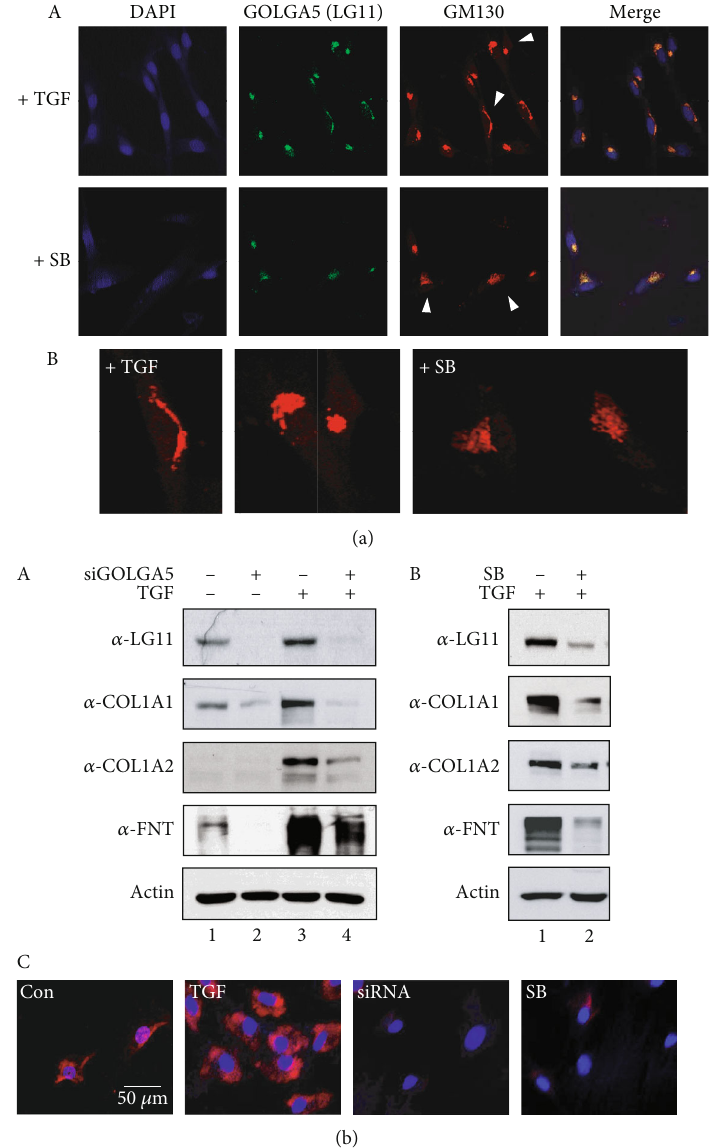
Figure 5: GOLGA5/LG11 is involved in synthesis of ECM proteins. (a) Inhibition of TGF- β 1-induced fi broblastic di ff erentiation by SB431542 treatment caused Golgi fragmentation. The structures of Golgi apparatus detected by Cy3-labeled GM130. Golgi marked with arrowheads in (A) are enlarged and shown in (B). (b) Synthesis of ECM proteins such as collagen type 1 and fi bronectin in PDL- fi broblastic progenitors was signi fi cantly blocked by decrease in GOLGA5 amount, as well as GOLGA5/LG11, collagen type 1 α 1, collagen type 1 α 2, and fi bronectin in fi broblastic cells were completely decreased by GOLGA5 depletion by siRNA (A) and SB431542 treatment (B). (C) Immunocytochemistry of endogenous collagen type 1. Expression of collagen type 1 in cells was detected by Cy3 signals. Nuclei were detected by DAPI